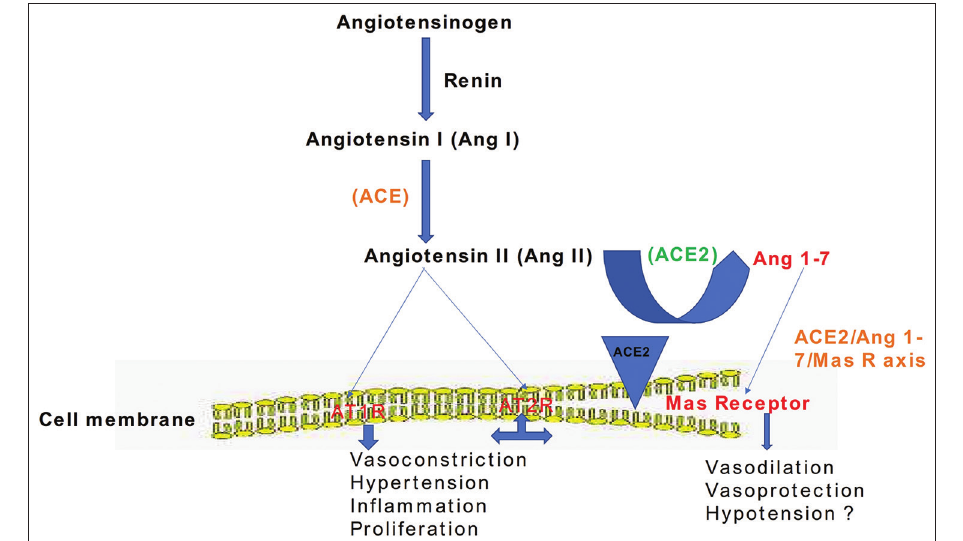
Figure-3: The potential benefits of angiotensin-converting enzyme 2/angiotensin-(1-7)/Mas axis and the implications of angiotensin type 1 receptor (AT1R).